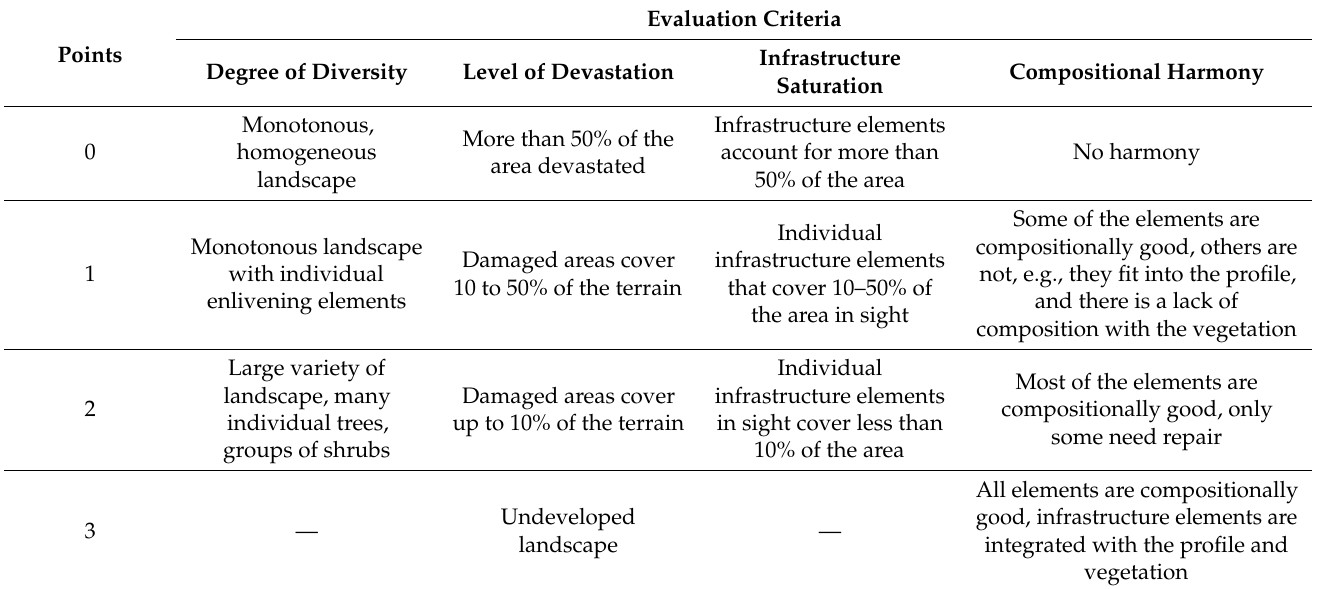
Table 4. Criteria used for assessing the aesthetic value of rural